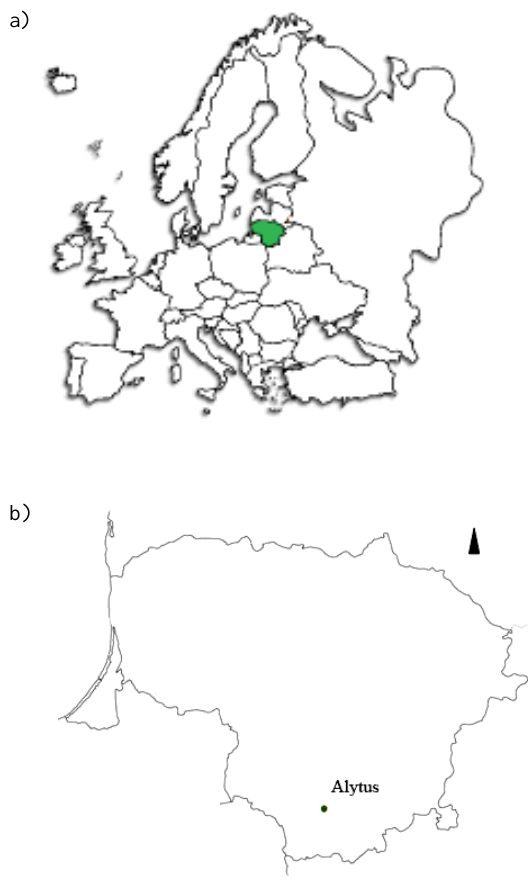
Fig. 1. Location of Lithuania in Europe (a); location of sampled tree (b) Soil in the investigated area is sandy loam with a mean pH of 5.5. Landscape is hilly with an inclination of 3–5 degrees. Forest litter thickness varies from 4 to 5 cm; mean annual temperature is around 6.0 ºC. South-western wind with speed of 4.2 m/s prevails in the region. Mean annual precipitation is 619 mm. Pines prevail in